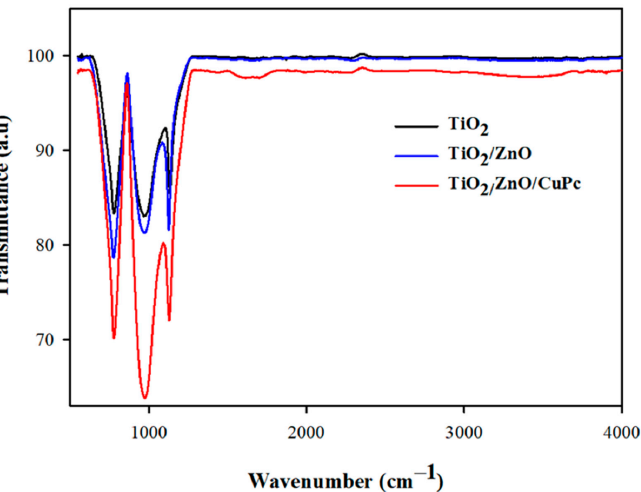
Figure 3. FT-IR spectra of TiO 2 thin film (black curve), TiO 2 /ZnO bilayer (blue curve), and TiO 2 /ZnO/CuPc heterostructure (red curve) grown on quartz